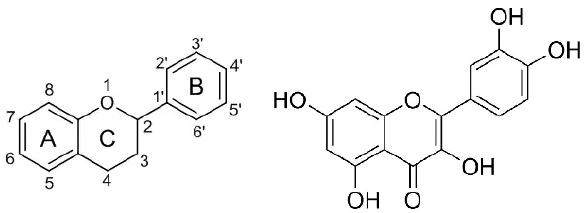
Figure 3. Common structure of flavonoids consisting of C(6)–C(3)–C(6) skeleton containing two aromatic rings (A,B) and one heterocyclic ring (C) with an oxygen atom (on the left) and the structure of quercetin (on the right), a member of the flavonoid family possessing the best structural requirements for α -dicarbonyl trapping ability (i.e., the hydroxyl group at C-5 on the A ring and the double bond between C-2 and C-3 on the C ring) [31].